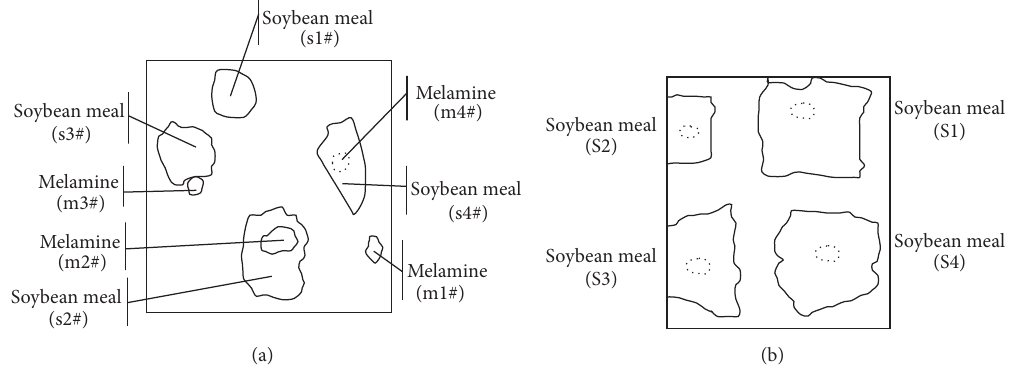
Figure 1: Experimental sample: (a) Set A-1; (b) Set A-2, melamine: line of